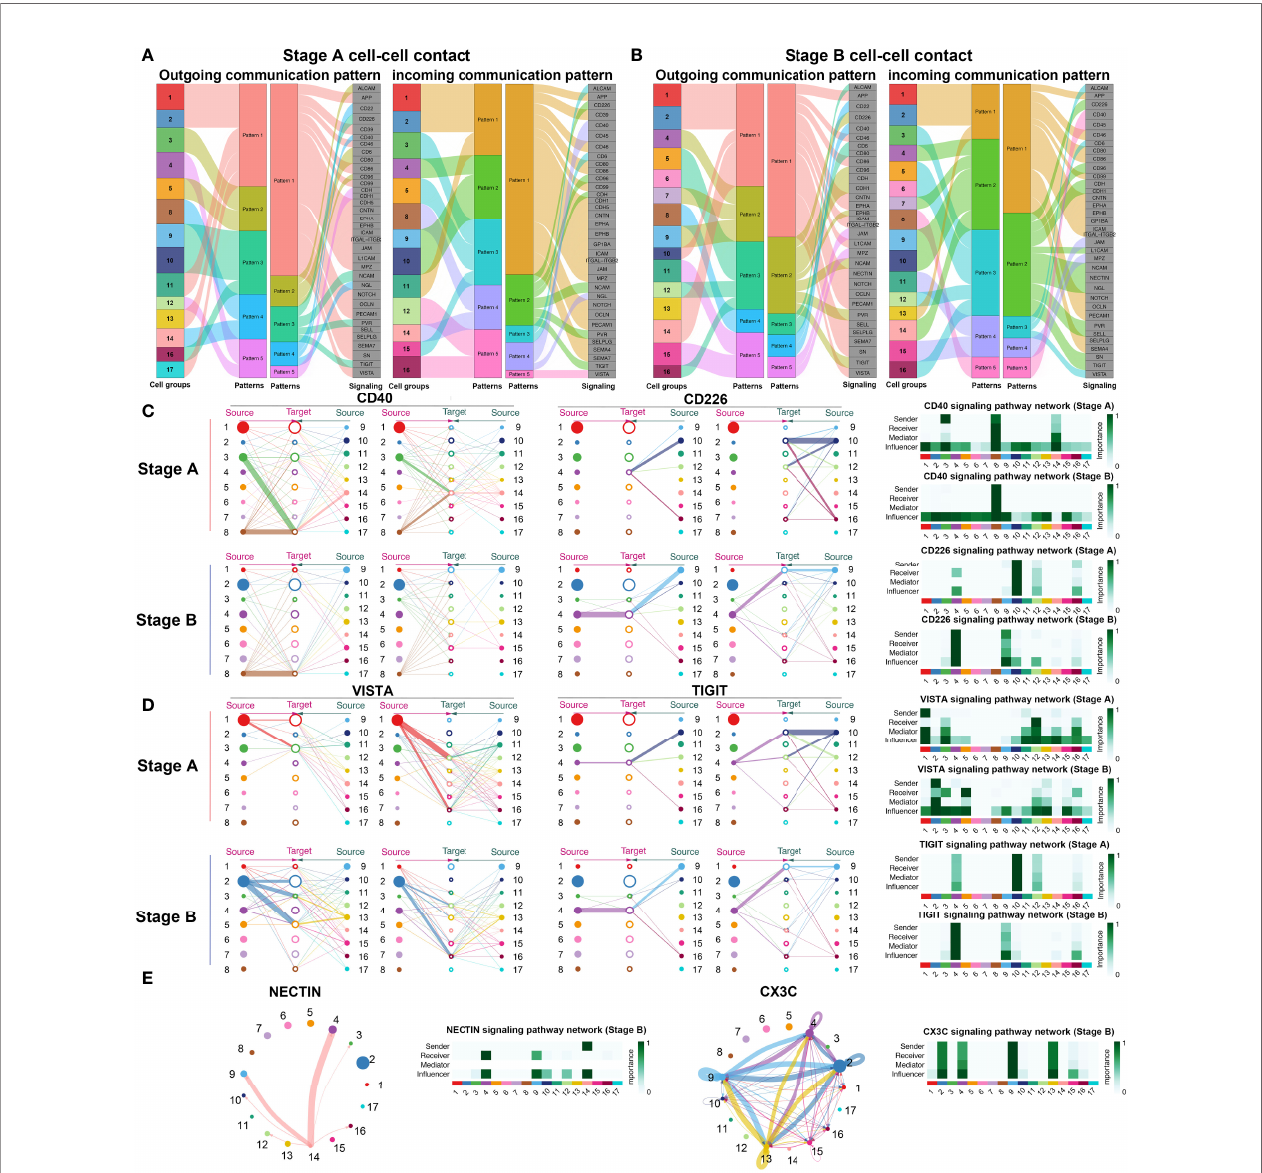
FIGURE 4 | Cell – cell contact communications among immune cells. (A) Outgoing and incoming communication patterns of cell – cell contact signaling pathways in stage A. Outgoing and incoming communication patterns of cell – cell contact signaling pathways clustered into fi ve patterns as indicated in the heatmap. In outgoing communication patterns, Clusters 1 – 17 are indicated as different colors and classi fi ed into fi ve patterns (patterns 1 – 5) except Clusters 6, 7, and 15, according to the outgoing signals they shared. Pattern 1 includes Cluster 1, Cluster 2 (CD14 + CD16 − monocytes), Cluster 11 (CD14 + CD16 − monocytes), Cluster 13 (CD14 dim CD16 + monocytes), and Cluster 17 (plasma cells). Pattern 2 includes Cluster 3 (CD4 + Tm) and Cluster 5 (CD4 + Tm). Pattern 3 includes Cluster 9 (NK), Cluster 10 (NK), and Cluster 16 (cycling CD8 + T). Pattern 4 includes Cluster 8 (memory B) and Cluster 14 (CD14 + CD16 dim monocytes). Pattern 5 includes Cluster 4 (CD8 + Teff) and Cluster 12 (CD8 + Teff). In incoming communication patterns, Clusters 1 – 17 were classi fi ed into fi ve patterns (patterns 1 – 5) except for Clusters 6, 7, 13, and 17. Pattern 1 includes Clusters 1, Cluster 2 (CD14 + CD16 − monocytes), and Cluster 11 (CD14 + CD16 − monocytes). Pattern 2 includes Cluster 4 (CD8 + Teff), Cluster 9 (NK), and Cluster 10 (NK). Pattern 3 includes Cluster 3 (CD4 + Tm), Cluster 5 (CD4 + Tm), and Cluster 15 (cDCs). Pattern 4 includes Cluster 8 (memory B) and Cluster 14 (CD14 + CD16 dim monocytes). Pattern 5 includes Cluster 12 (CD8 + Teff) and Cluster 16 (cycling CD8 + T). Signals included in these patterns are indicated in gray boxes. (B) Outgoing and incoming communication patterns of cell – cell contact signaling pathways in stage B. Outgoing and incoming communication patterns of cell – cell contact signaling pathways clustered into fi ve patterns as indicated in the heatmap. (C) Hierarchical network of activated signals in stages A, B. (D) Hierarchical network of inhibitory signals in stages A, B. Signals sent by speci fi c cluster are drawn with the same color indicated in (A) . Source and target of signaling pathways are connected by lines. Thickness of lines indicate the degree of the signal. Sender, receiver, mediator, and in fl uencer of speci fi c signals are indicated in individual heatmap. (E) Signals detected uniquely in stage B. Thickness of lines indicate the degree of the signal. Sender, receiver, mediator, and in fl uencer of speci fi c signals are indicated in individual